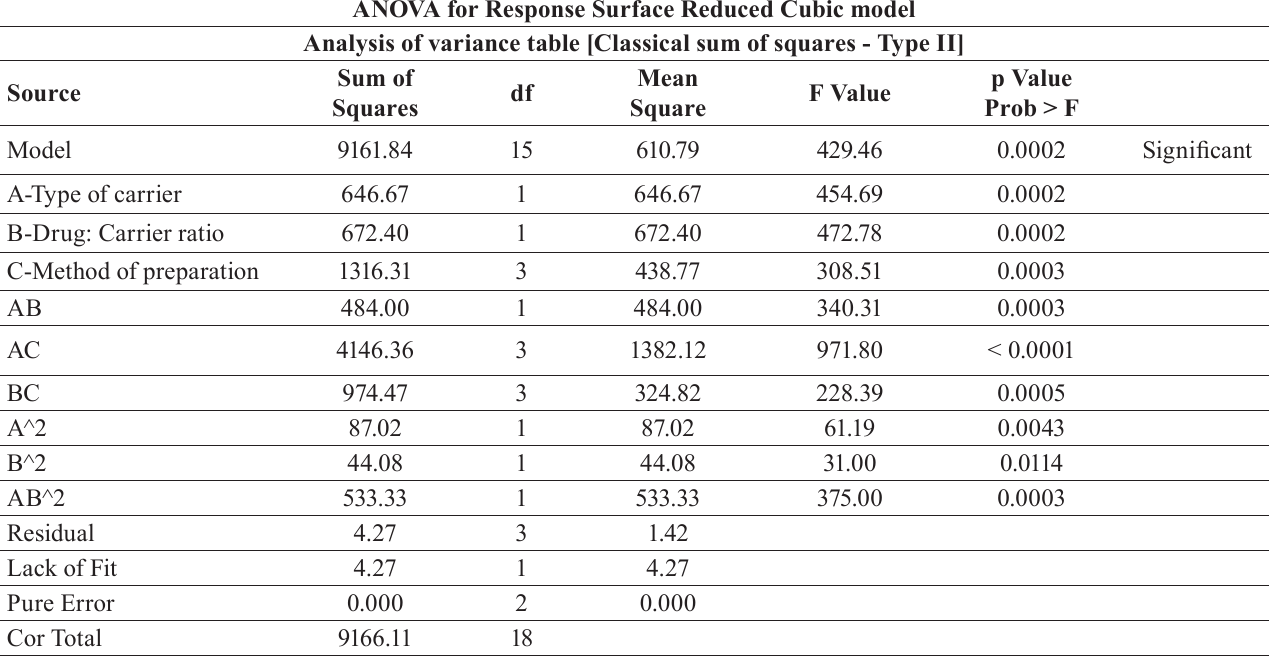
TABLE S2 - ANOVA table for the response variable solubility along with the polynomial equation ANOVA for Response Surface Reduced Cubic model Analysis of variance table [Classical sum of squares - Type